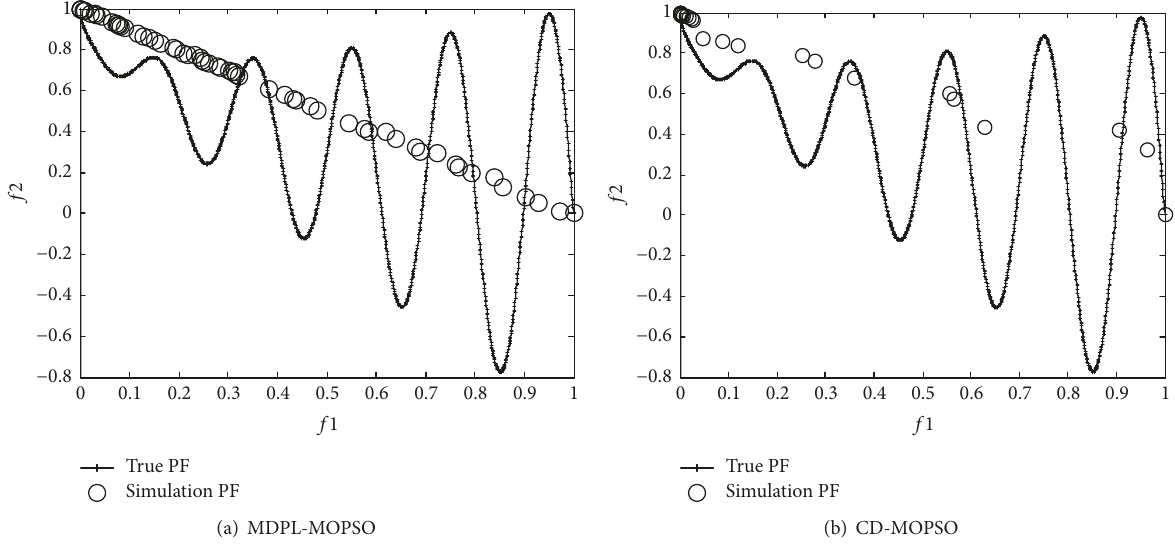
Figure 10: Nondominated solutions with MDPL-MOPSO and CD-MOPSO on